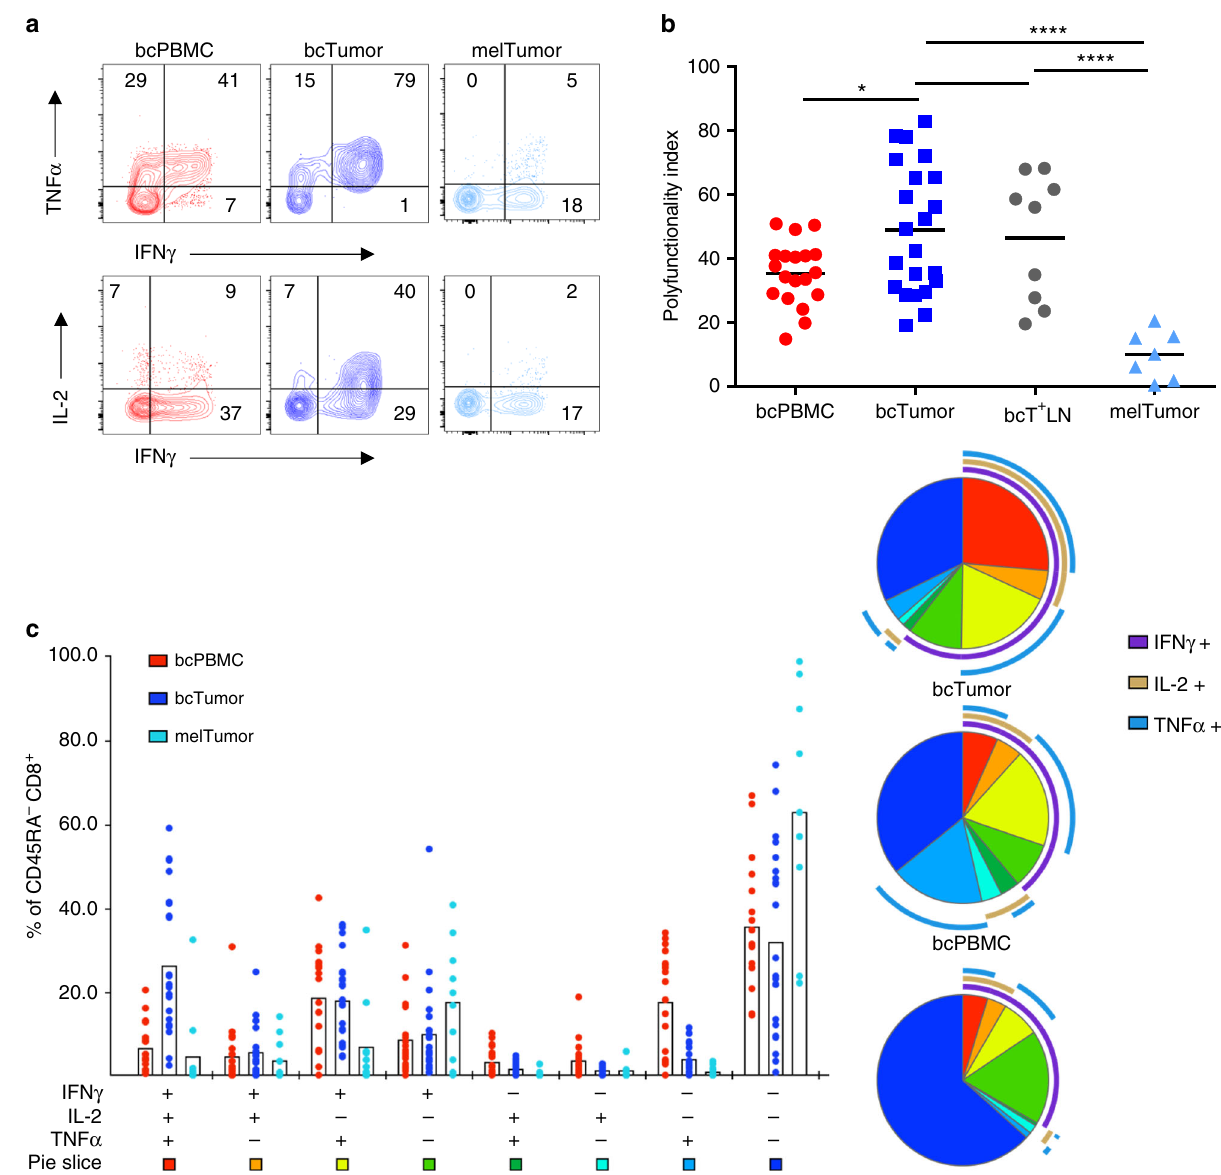
Fig. 5 CD8 + TILs from breast tumors retain polyfunctional effector cytokine production capacity for cytokines. a CD8 + T cells from bcPBMCs, bcTumor, bcT + LN, and melTumor tissues were stimulated with PMA and ionomycin for 4 h followed by intracellular staining for IFN γ , TNF α , and IL-2 production. Representative contour plots of fl ow cytometry data are shown. b Graph depicts calculated polyfunctionality indices for each sample type based on frequencies of non-naive CD8 + T cells expressing IFN γ , TNF α , and IL-2. Each symbol represents a single patient tissue sample. c SPICE graph visualizes frequencies of non-naive CD8 + T cells expressing IFN γ , TNF α , and IL-2 in bcPBMCs, bcTumor, melTumor with each symbol representing one patient tissue sample in each category. Summary pie graphs generated represent adjusted means for each population color-coded in the bar graph and display the phenotype of IFN γ , TNF α , and IL-2 production in those populations. Signi fi cance was calculated using one-way ANOVA and Holm – Sidak multiple comparison tests; * p < 0.05; *** p <